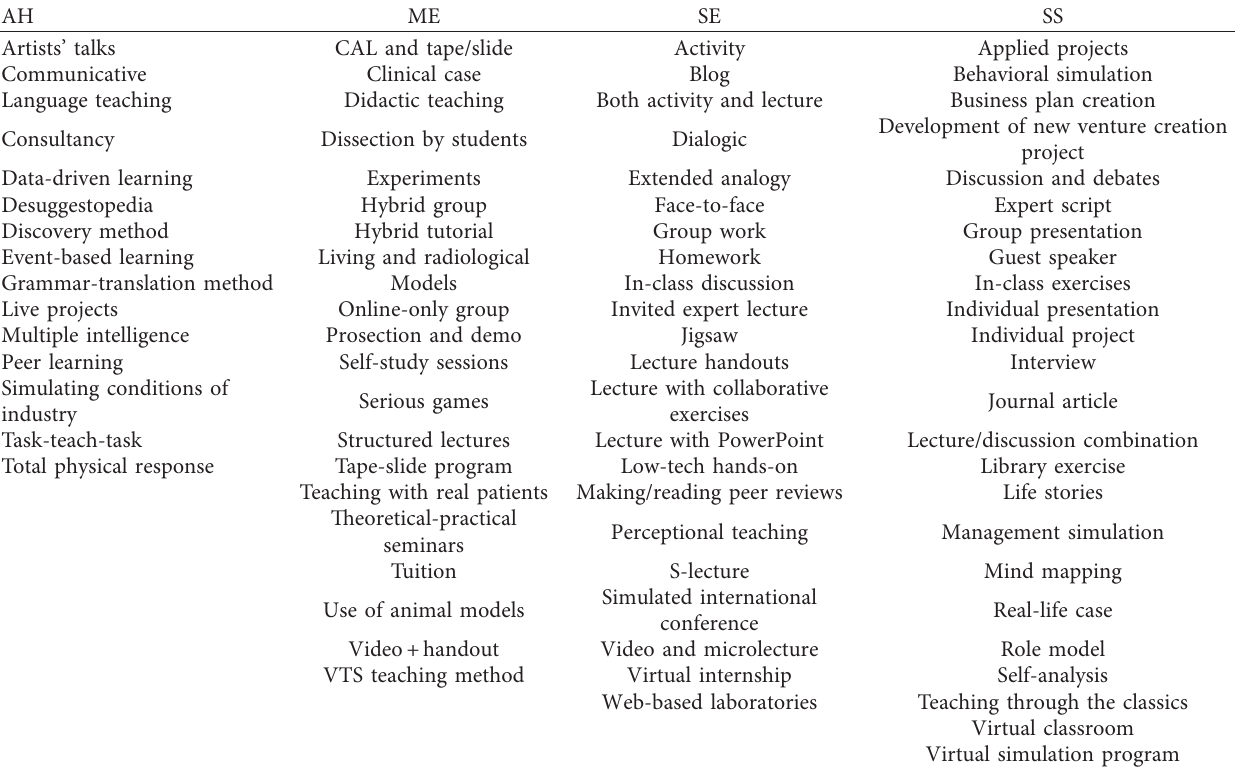
Table 2: TMs exclusively being practiced in each